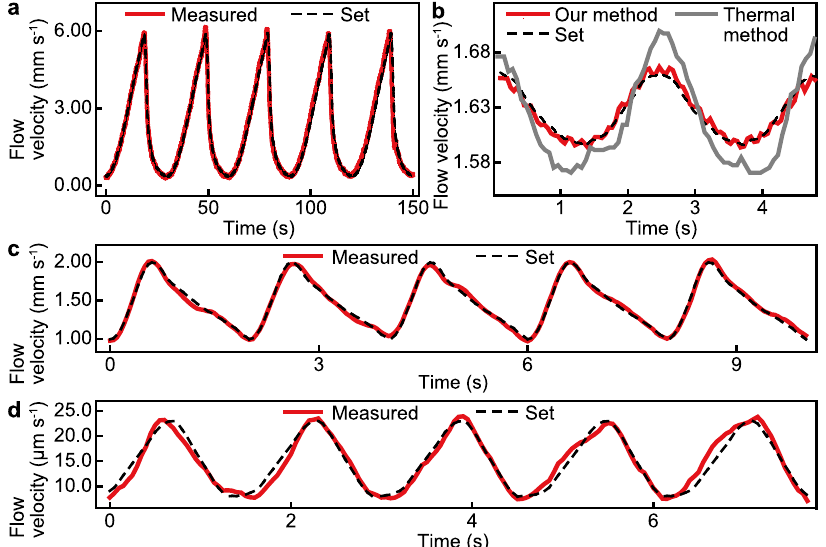
Fig. 4 Real-time interrogation of pump-driven time-varying whole-blood fl ows using the graphene devices. The measured velocities of the sawtooth-like ( a ) and sinuous ( b ) fl ows and the fl ows whose waveforms simulate those of the blood fl ows through murine deep-brain capillaries ( c ) and human retina capillaries ( d ). The velocity of the sinuous fl ow ( b ) measured by the graphene device shows 6-Hz, <10 µ m s − 1 periodic steps generated by the stepping motion of the stepper motor of the syringe pump. In a – d , the red lines represent the results of our real-time measurement using the graphene devices and the dashed lines represent the fl ow velocities set by the syringe pump. The gray line in b represents the fl ow velocity measured by using a calorimetric fl